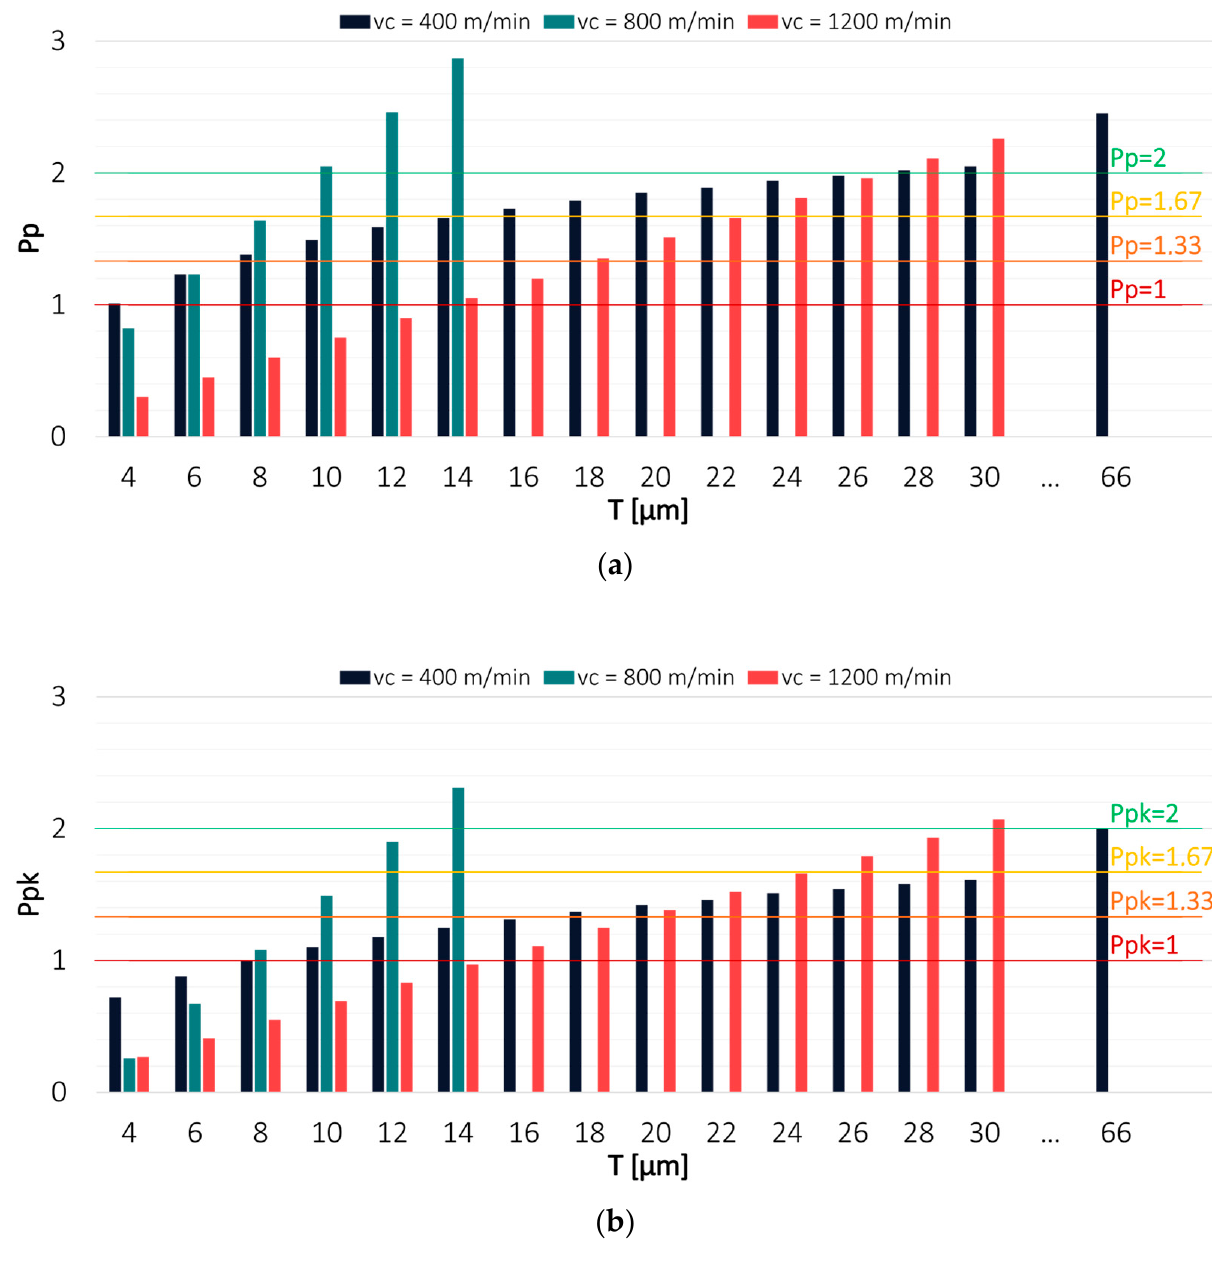
Figure 4. Values of ( a ) Pp and ( b ) Ppk for the results obtained in a milling process conducted with variable cu tt ing speed and TiAlN-coated tool.